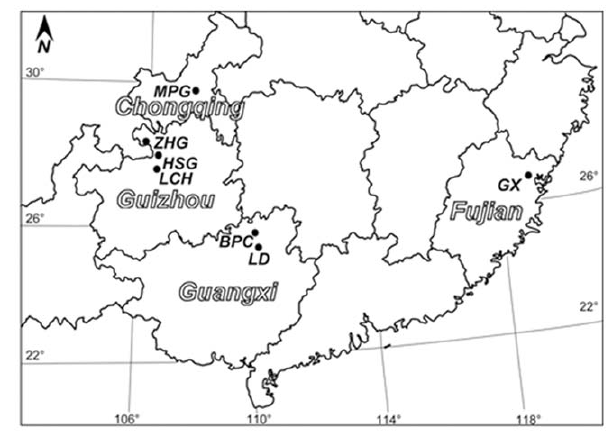
Figure 1. Locations of Alsophilaspinulosa populations examined in this